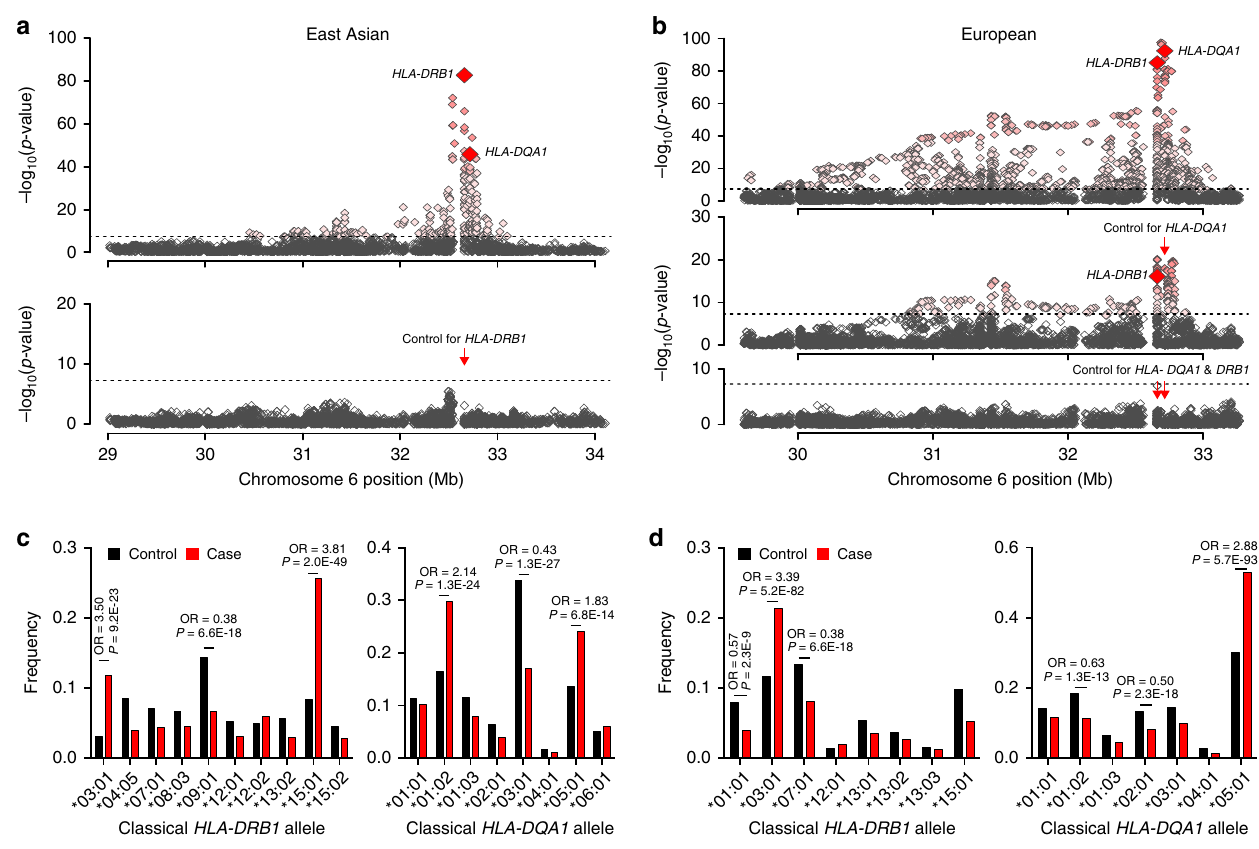
Fig. 2 Ethnicity-speci fi c association analyses point to HLA-DRB1 and HLA-DQA1 as the top associated genes. a Regional plot for East Asian cohorts that includes association statistics for all imputed variants and classical HLA alleles; the strongest association signal was for HLA-DRB1 gene (upper panel); the results for HLA-DQA1 gene are highlighted for reference; after adjusting for all DRB1 classical alleles (red arrow), there were no residual associations across the entire 3-Mb region (lower panel). The dotted horizontal line indicates the genome-wide signi fi cance threshold ( α = 5 × 10 − 8 ). b In Europeans, the strongest HLA gene association was for the HLA-DQA1 gene (upper panel); after controlling for all classical DQA1 alleles (red arrow), HLA-DRB1 gene remained genome-wide signi fi cant (middle panel); after controlling for both DRB1 and DQA1 , there were no signi fi cant associations in the region (lower panel), suggesting that variation in both genes explains the entire signal. c East Asian frequency distributions of classical DRB1 and DQA1 alleles (four-digit resolution) for cases (red) and controls (black); unadjusted ORs and P -values provided for genome-wide signi fi cant alleles. d The European frequency distributions of classical DRB1 and DQA1 alleles (four-digit resolution) for cases (red) and controls (black); unadjusted ORs and P -values provided for genome-wide signi fi cant